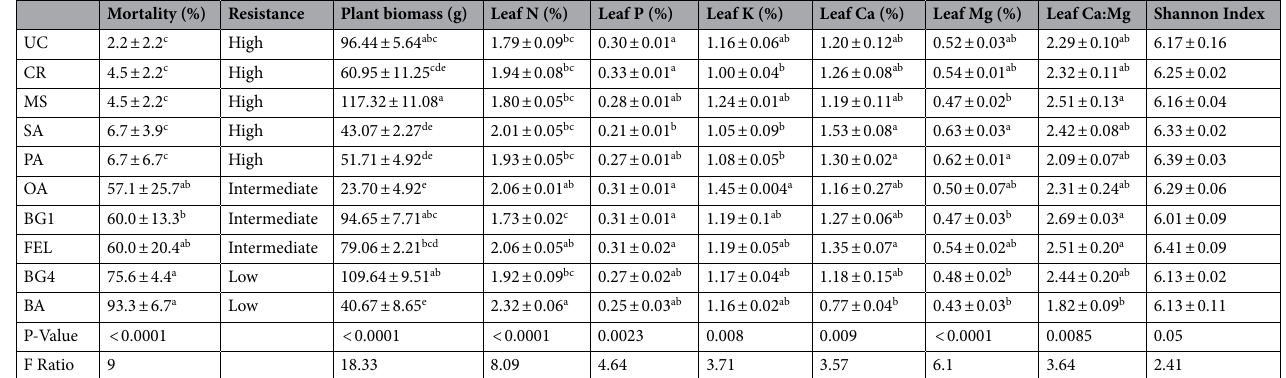
Table 2. Aboveground traits (biomass and leaf nutrient contents), rhizosphere microbial diversity (Shannon Index) and mortality of the strawberry cultivars grown in the presence of the soil-borne fungal pathogen Verticillium dahliae . Values are means of three replicates ± standard error. Different letters within the same column indicate significant differences at p < 0.005.